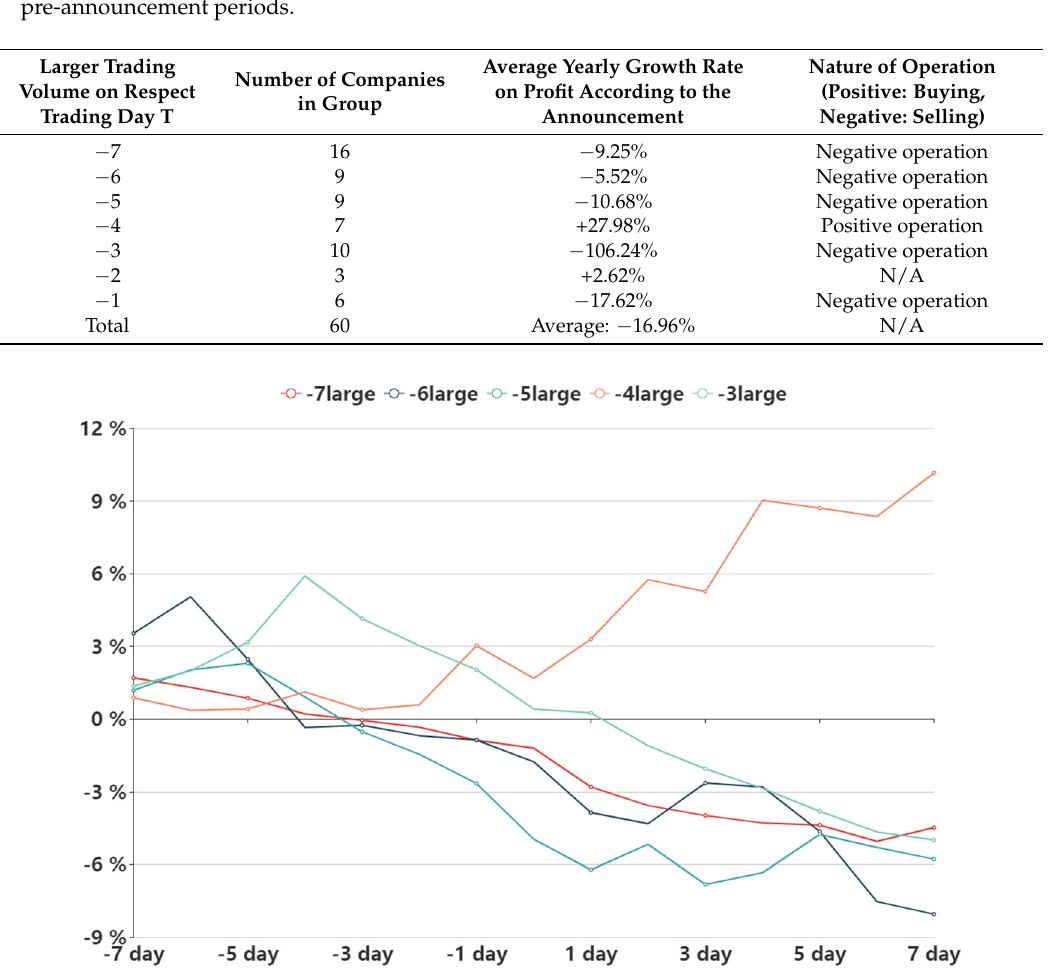
Figure 2. Distribution of the larger trading volume groups in different trading days.